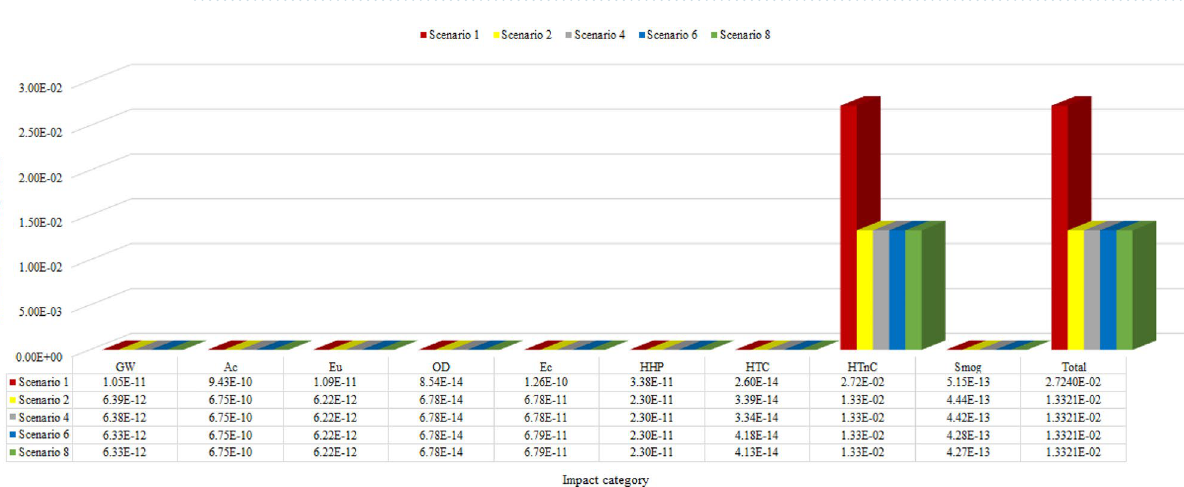
Figure 4. Line graph with two axes and the five scenarios representing the relative contribution in percentage by impact category by categories, highlighted the HTC scenarios 2 and 4 with a percentage of 28.29% above the threshold level of 100%.